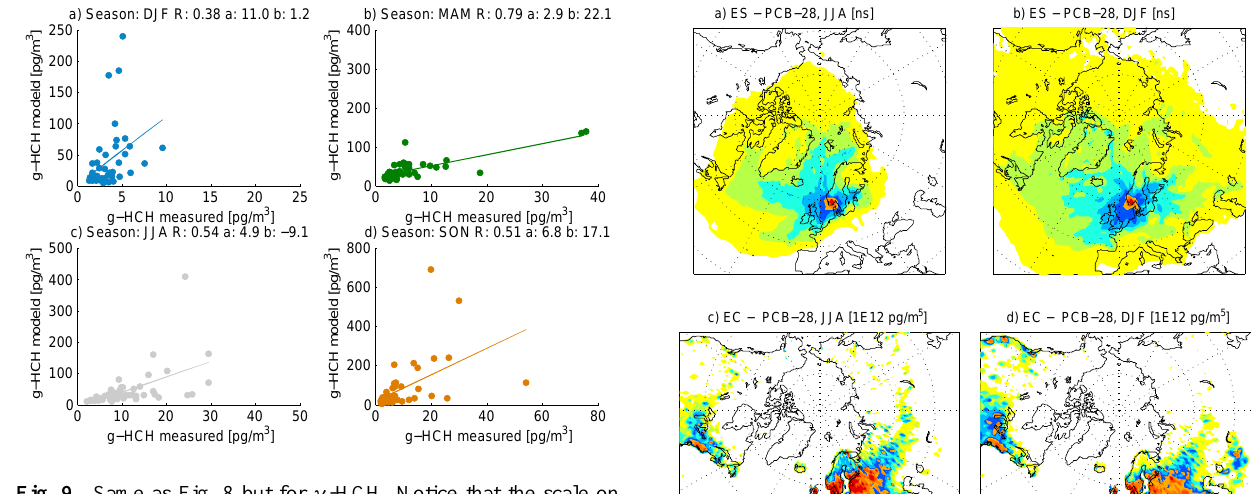
Fig. 9. Same as Fig. 8 but for γ -HCH. Notice that the scale on the ordinate extends to ten times larger values than the scale on the abscissa.